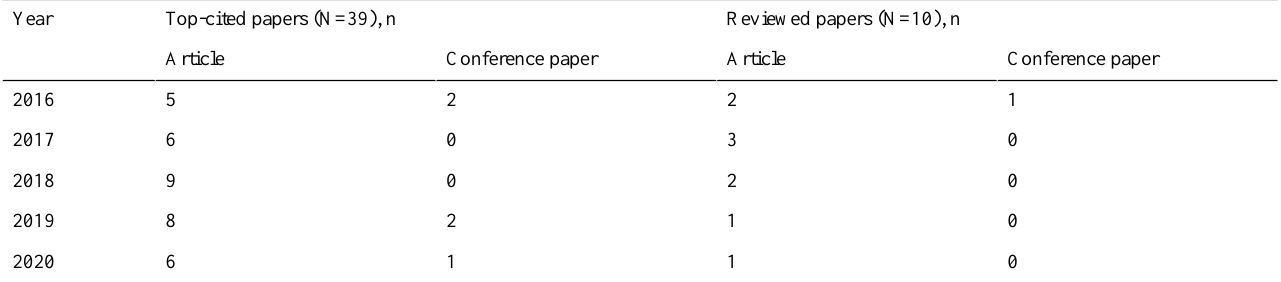
Table 8. Overview of the top 5 most cited papers by